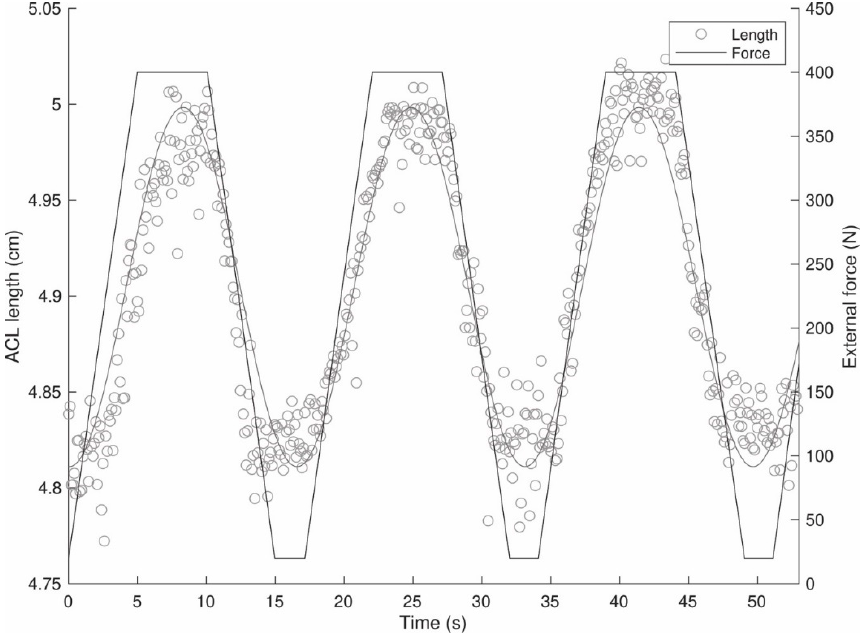
Figure 3. Screenshot of MRI cine sequence with points tracked for the estimation of ACL elongation. The red dots represent the points tracked during test execution.